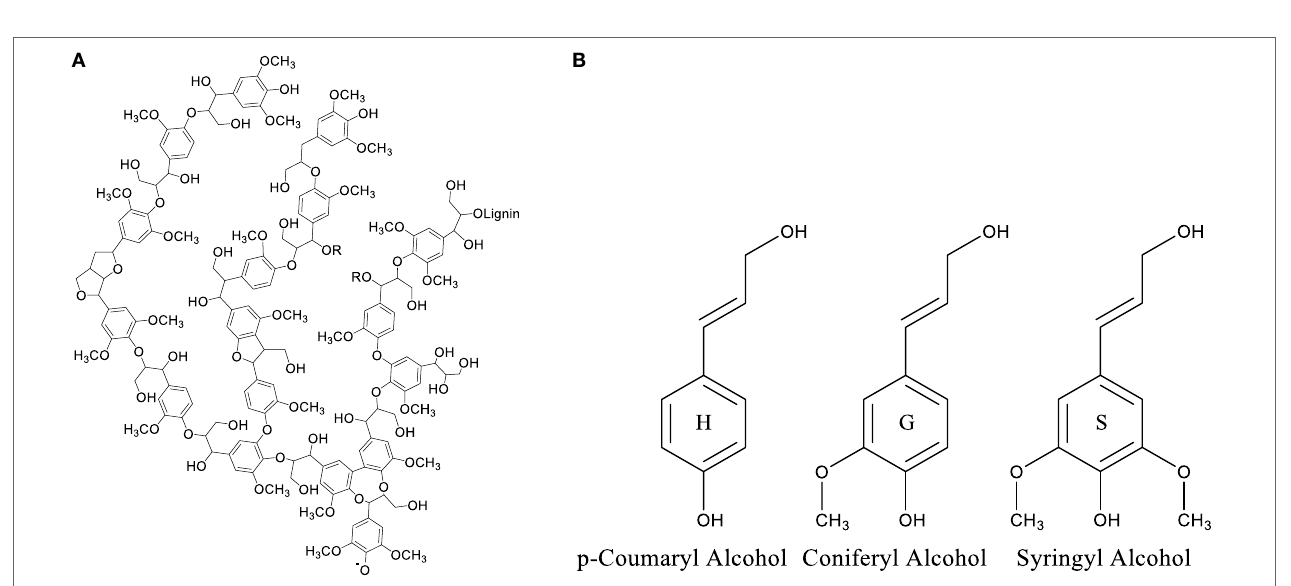
FigUre 4 | Scheme of the reaction between an isocyanate group and a urethane linkage to form an allophanate linkage.